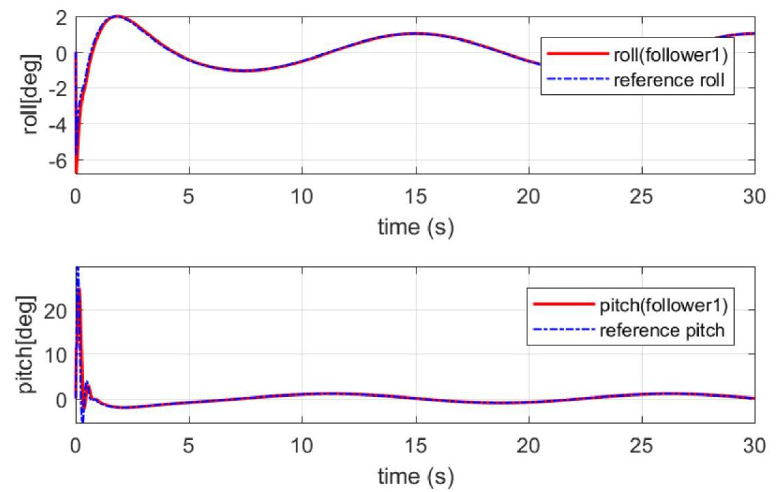
Figure 6. The reference angles of the first follower quadrotor for the proposed formation control: the dashed line indicates the reference attitude angles that enable the quadrotor to converge to the desired formation, and the solid line is the result of the simulation about attitude responses of the first follower quadrotor.